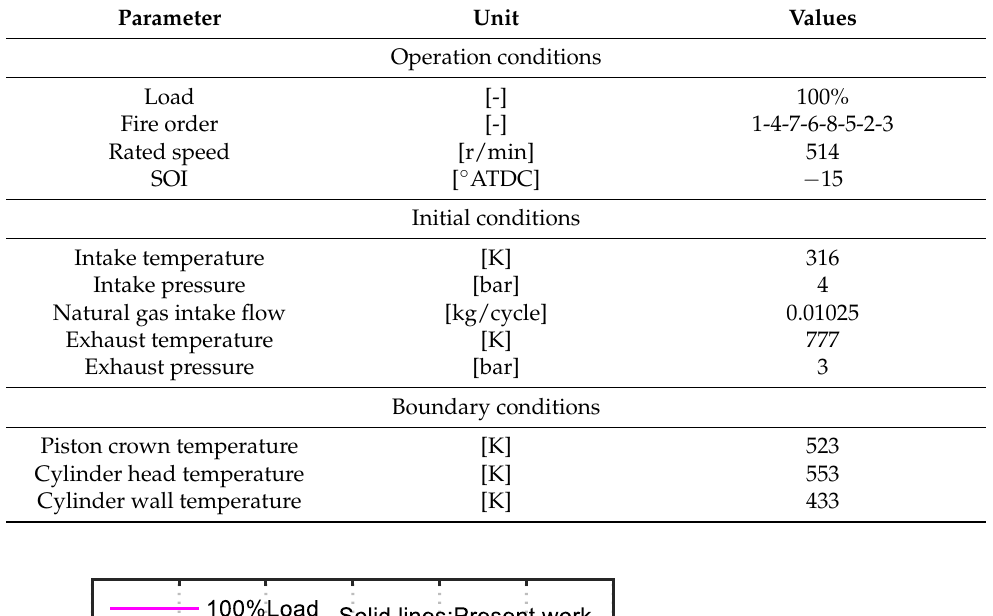
Table 3. The boundary, initial, and operation conditions for the model.